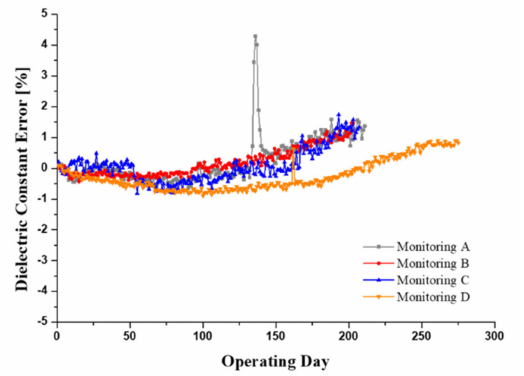
Figure 13. Dielectric constant monitoring results of four excavators over a 12 month